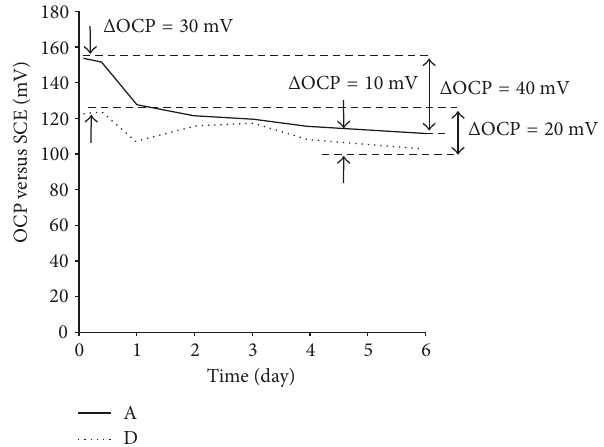
Figure 2: Evolution of OCP values of the sensors A and D in chloride-free simulated pore solution